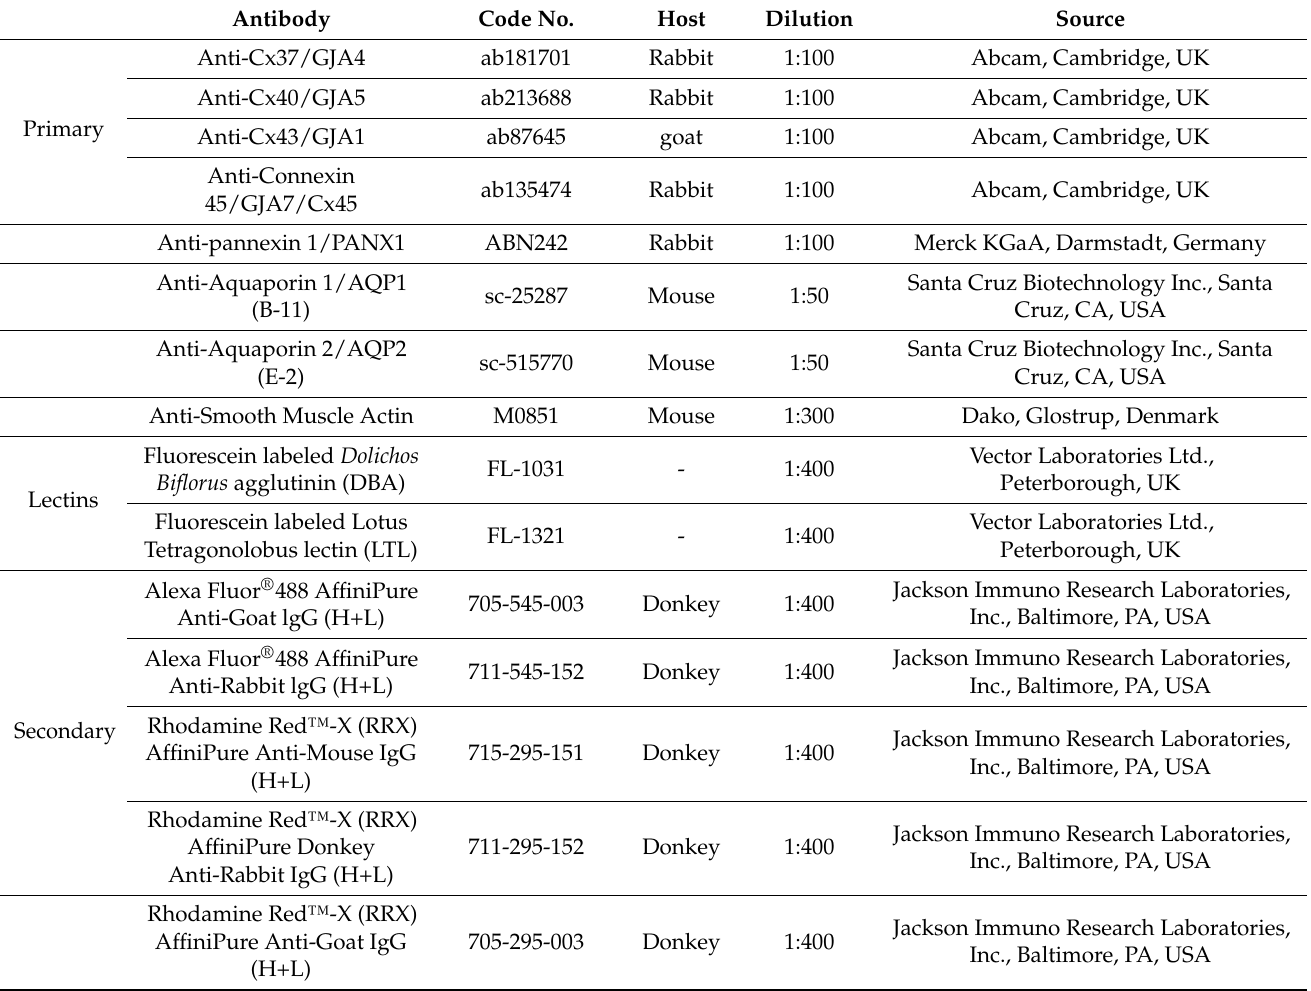
Table 1. Primary and secondary antibodies